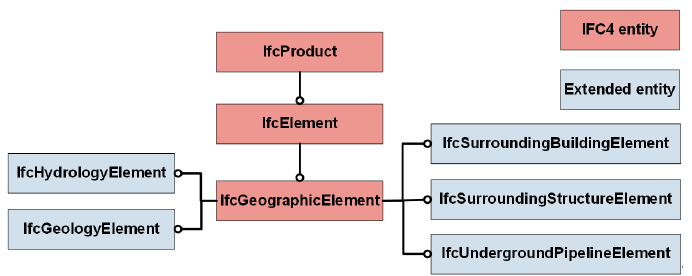
Figure 10. IFC expression of the environment information